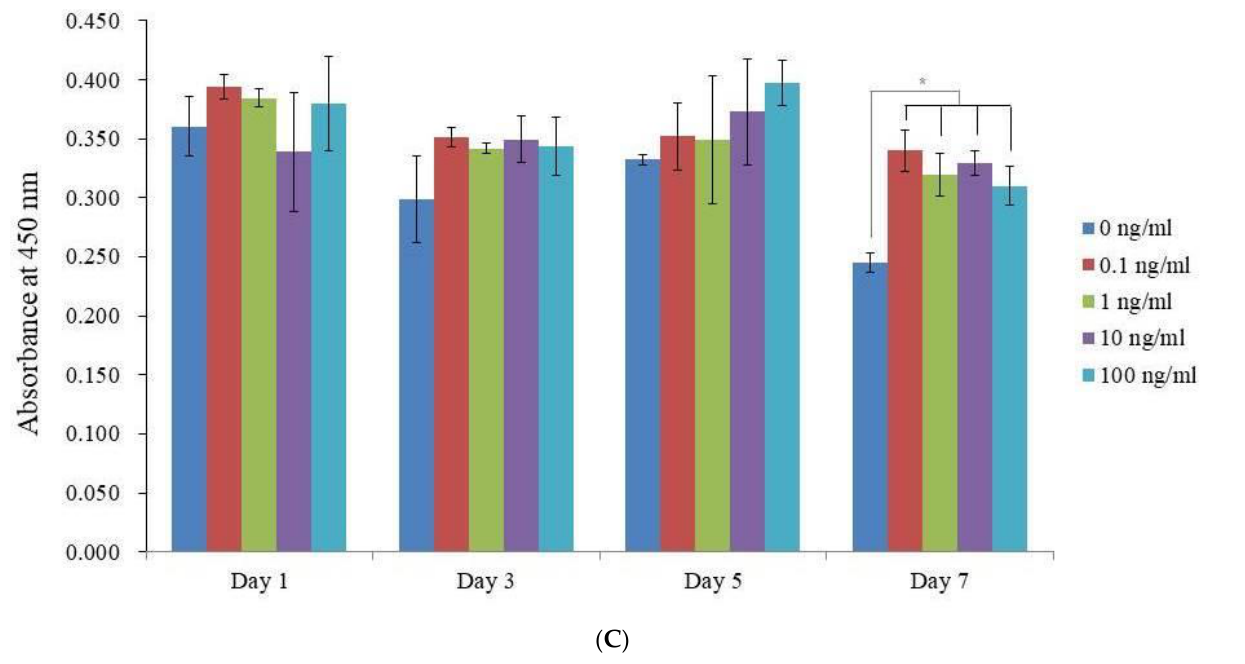
Figure 2. Cellular viability assessment. ( A ) Stem cell spheroids on day 1 with live, dead, and merged cell pictures. ( B ) Stem cell spheroids on day 7 with live, dead, and combined cell pictures. (Original magnification: 100) The scale bar denotes 100 μ m. ( C ) Cell viability measured on days 1, 3, 5, and 7 using the Cell Counting Kit-8. * On day 7, p < 0.05 compared to the time-matched 0 ng/mL group.